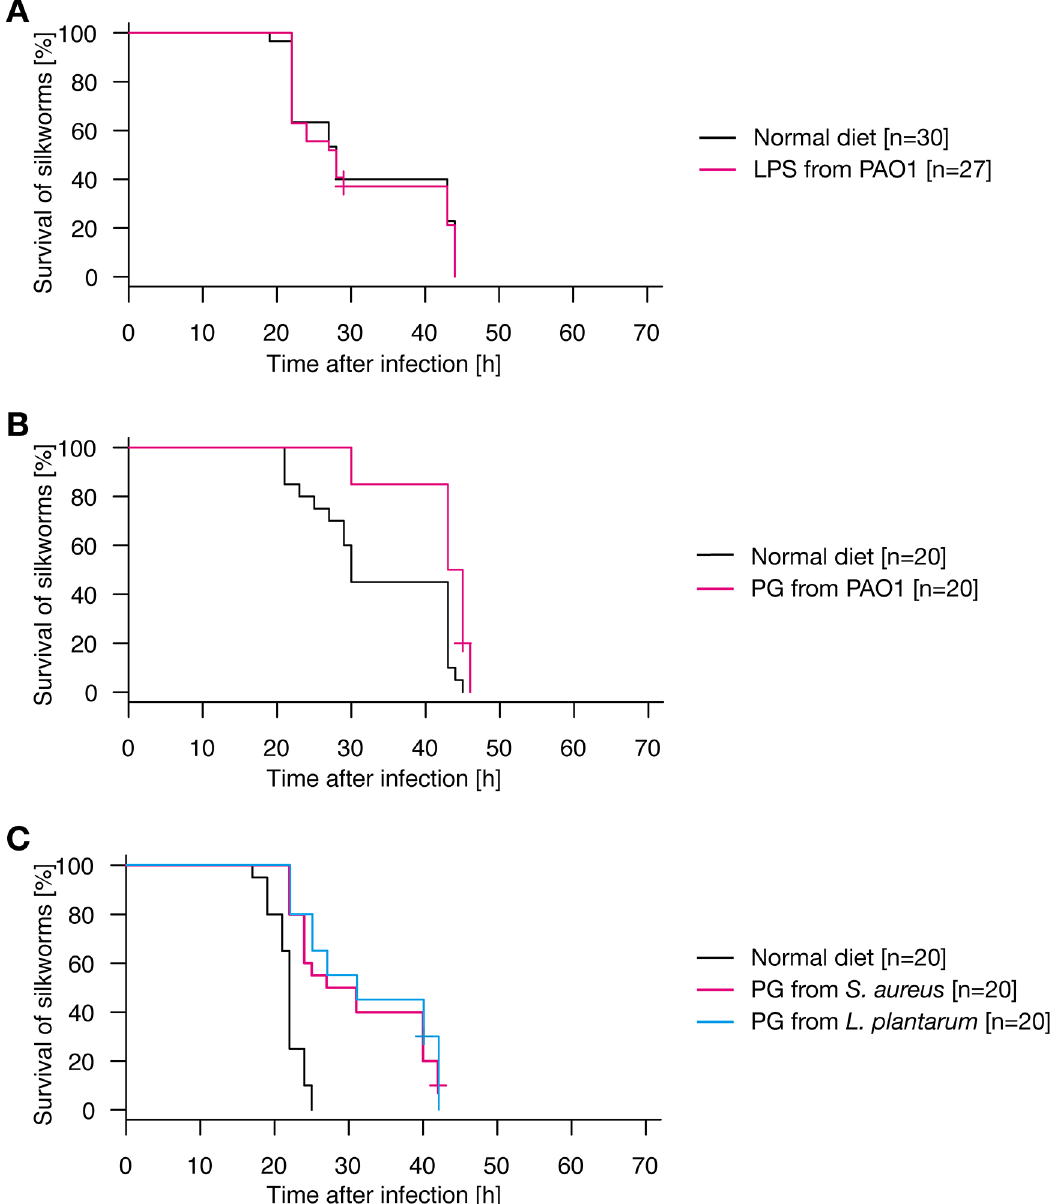
Fig 4. Oral administration of P . aeruginosa peptidoglycan leads to infection resistance of silkworms against P . aeruginosa . A. Silkworms were fed a normal diet (n = 30) or a diet containing P . aeruginosa lipopolysaccharides (n = 27) for 2 d and then injected with P . aeruginosa . Results from three independent trials (S2 Table, exp. 1 – 3) were combined into a single analysis. The combined survival curve is shown in the figure. Survival of silkworms fed the normal diet did not differ significantly from that of silkworms fed the diet containing lipopolysaccharides (p = 0.893). None of the mock-infected silkworms died (S2 Fig). B. Silkworms were fed a normal diet (n = 20) or a diet containing P . aeruginosa peptidoglycans (n = 20) for 2 d, and then injected with P . aeruginosa . Results from two independent trials (S2 Table, exp. 4 – 5) were combined into a single analysis. The combined survival curve is shown in the figure. The survival of silkworms fed the diet containing P . aeruginosa peptidoglycans was significantly longer than that of silkworms fed the normal diet (p = 1.76E-04). None of the mock-infected silkworms died (S2 Fig). C. Silkworms were administered a normal diet (n = 20), diet containing S . aureus peptidoglycans (n = 20), or diet containing L . plantarum peptidoglycans (n = 20) for 2 d, and then injected with P . aeruginosa . Results from two independent trials (S2 Table, exp. 6 – 7) were combined into a single analysis. The combined survival curve is shown in the figures. Survival of silkworms fed a diet containing S . aureus or L . plantarum peptidoglycans was significantly longer than that of silkworms fed a normal diet (p = 5.62E-06 or 3.37E-07). None of the mock-infected silkworms died (S2 Fig).